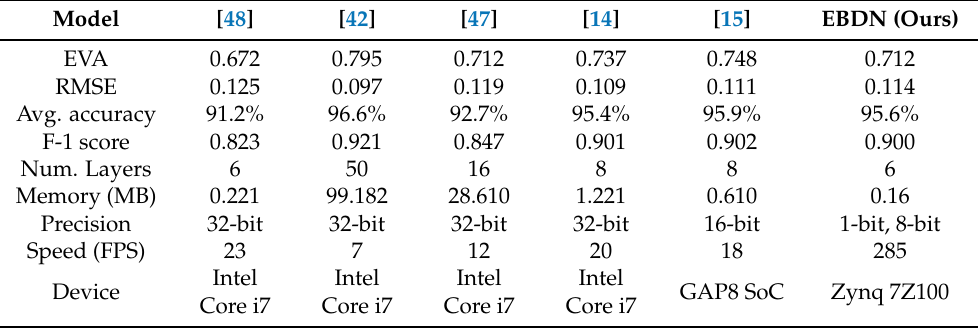
Table 2. Comparison with other full precision models on performance of steering regression task and collision prediction task.